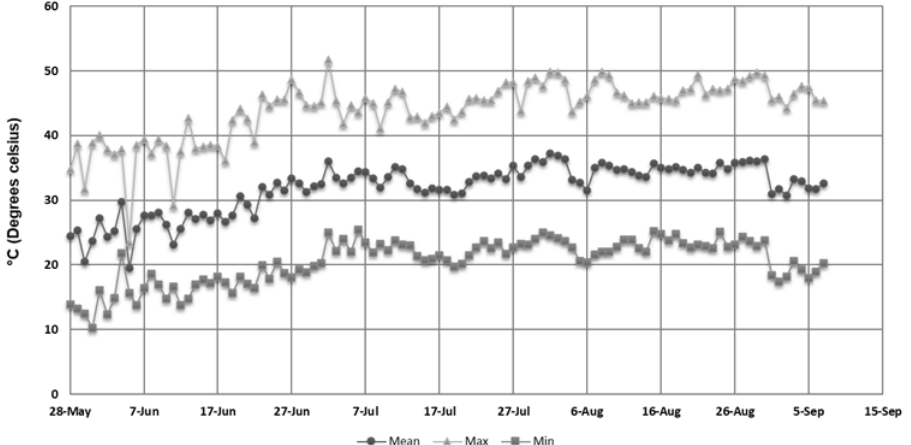
Figure 1. Monthly temperature trend: maximum, minimum, and mean temperature (°C) recorded during the growing season under the greenhouse.